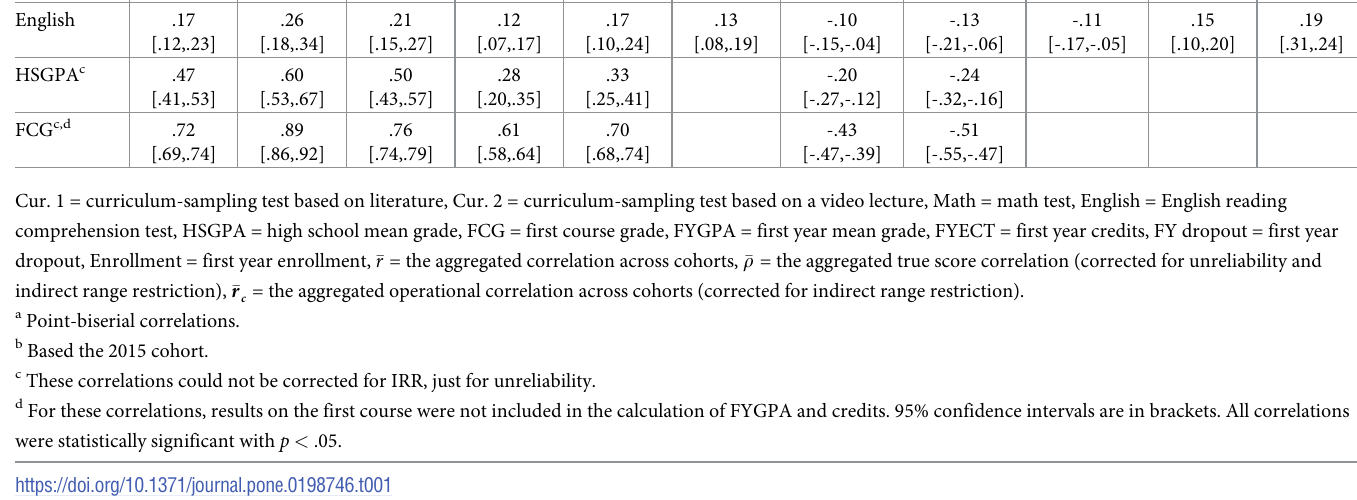
( r = .29), and a small negative correlation with dropout ( r c ple, the correlation between the scores on both curriculum-sampling tests equaled r = .51. In addition, the video-lecture test showed very small incremental validity for predicting FYGPA over the literature-based curriculum-sampling test ( Δ R 2 = .01, R 2 = .20, Δ F .02, and based on the corrected correlations, Δ R 2 Specific skills tests and grades as predictors. The operational validities of the math and English skills tests were less consistent across cohorts (S3 Table) and the aggregated opera- tional validities were moderate to small for all outcome measures. The data needed to check for and, if needed, correct for range restriction in HSGPA were not available, so we only com- puted correlations corrected for unreliability with the academic outcomes.